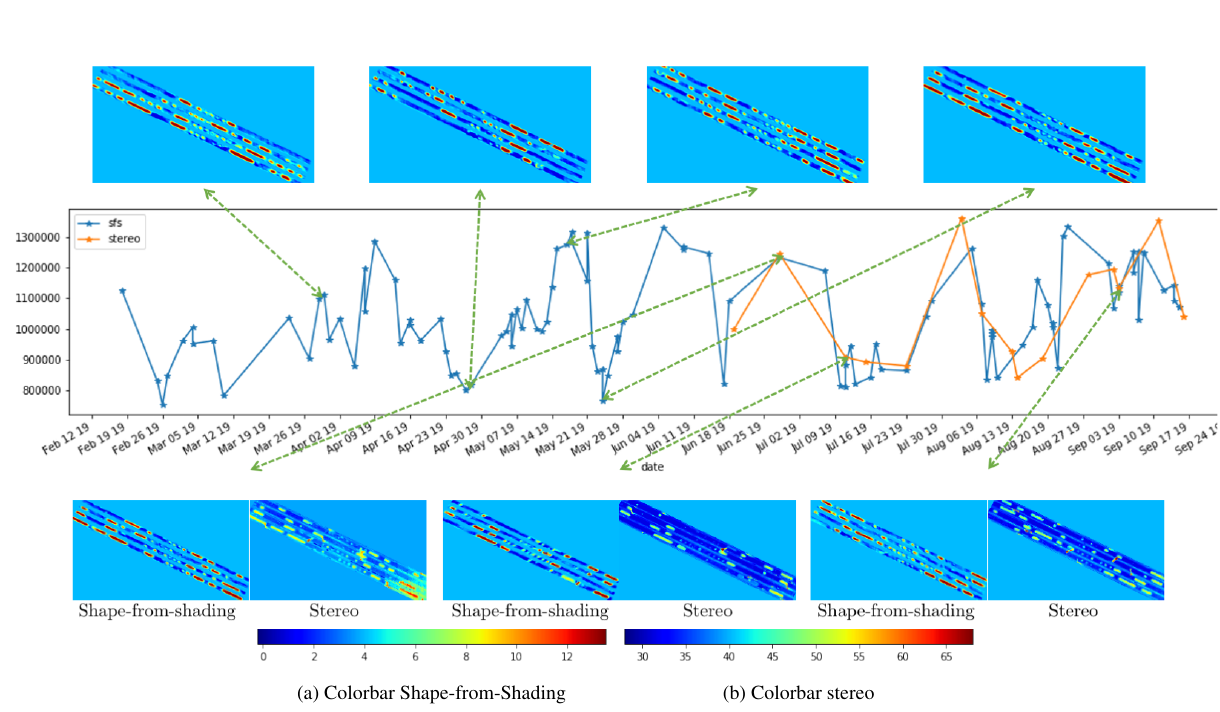
Figure 6. Volume tracking in a time series. The plot represents the estimated volumes using the algorithm described in Section 3 on a time series of PlanetScope images spanning 7 months. The Shape-from-Shading heights are scaled by a constant so that the maximum altitude of our stockpiles matches the one from a reference stereo reconstruction (about 15m). The results for some highlighted dates are shown above the plot. The results of our method are consistent with the volumes obtained using stereo reconstruction and are obtained with a much higher frequency. The images shown below the plot allow the comparison on 3 dates of our result with 3D reconstructions. Note that the altitudes in the 3D reconstructions are expressed relative to the